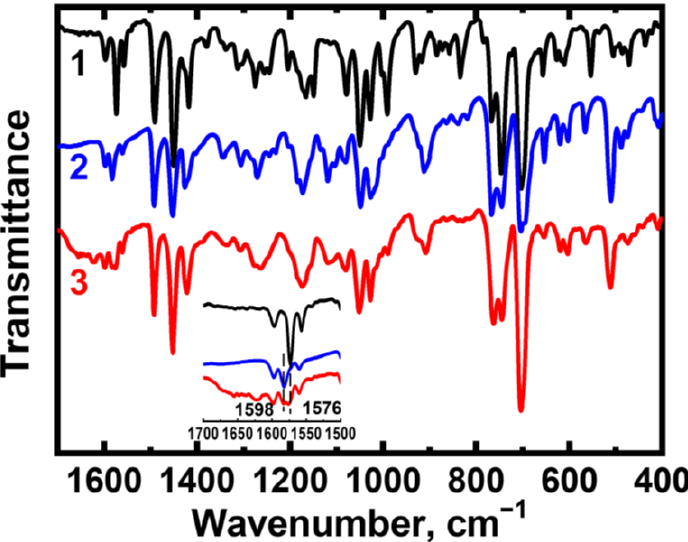
Figure 2. IR spectra of free ligand L (1), powder sample of Cu 4 I 4 L 2 (2) and dried Cu 2 I 2 L 3 colloids (3). Inset shows the region from 1700 to 1500 cm –1 .